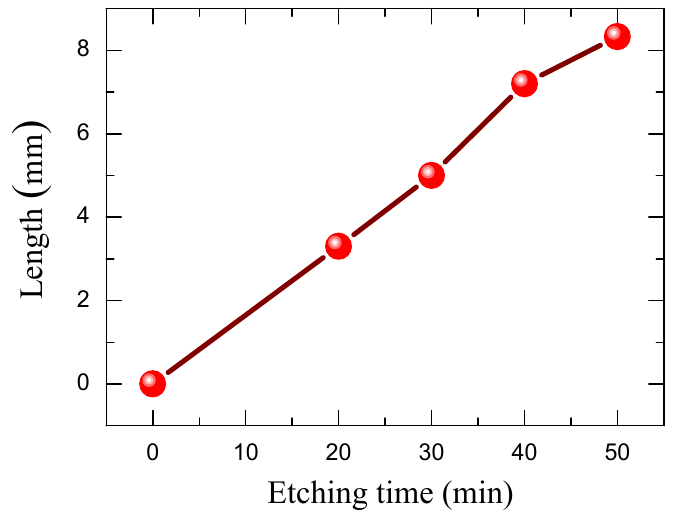
Figure 4. Length of Si NWs as a function of Ag-assisted chemical etching time. Figure 5 depicts a magnified SEM surface image of the PbS/SiNWs nanohybrids and the corresponding EDX spectrum. The elements Pb, S, Ag, Si, and O were detected, confirming the purity of the PbS films. However, the SiNWs still contain Ag residue even after Ag etching at the end of the SiNWs formation (Table 1).